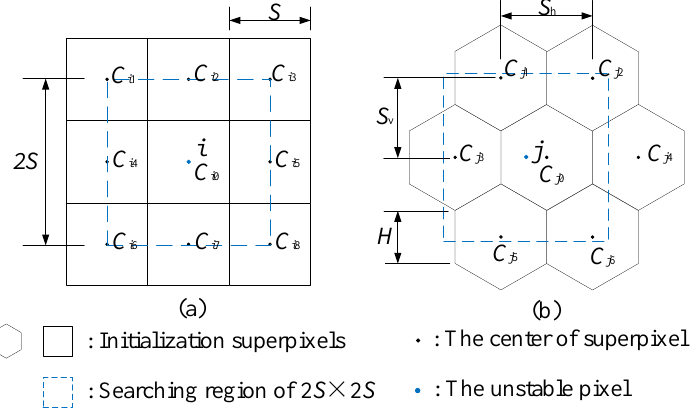
Figure 2. Distribution of Cluster Centers. ( a ) Square distribution. ( b ) Hexagonal